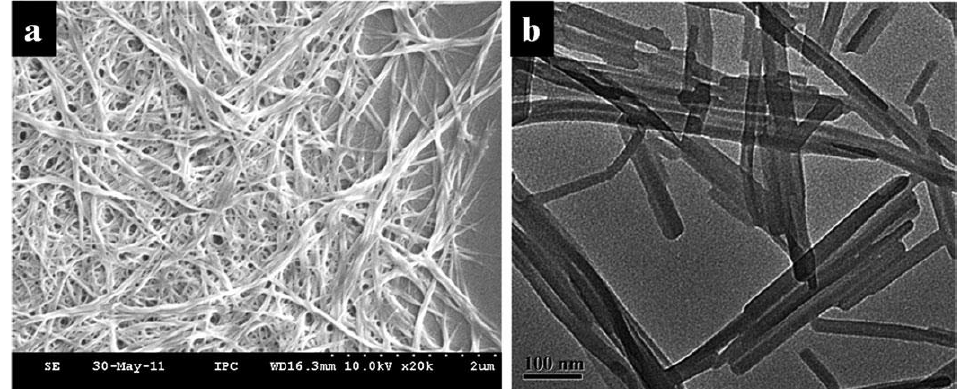
Figure 2. ( a ) SEM and ( b ) TEM images of nanowires of 17 .